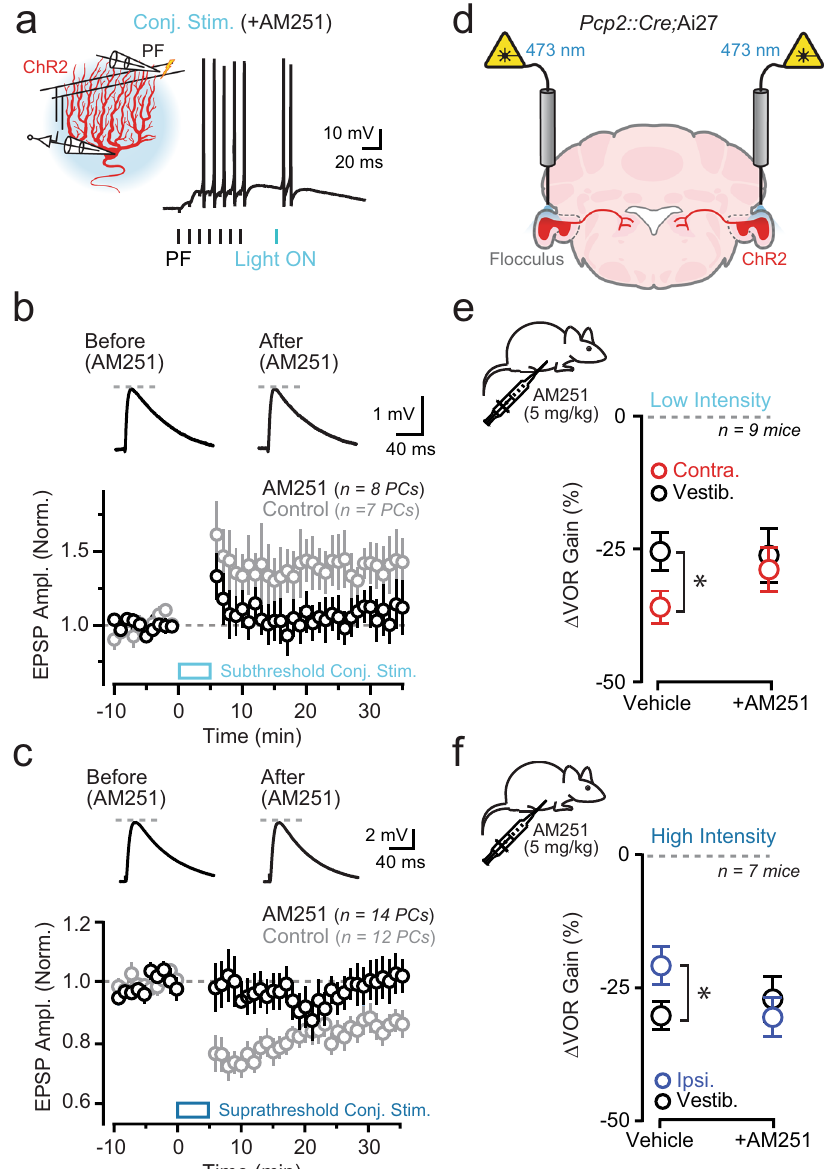
Fig. 4 Optogenetically induced plasticity and learning requires endocannabinoid signaling. a In the presence of the CB 1 receptor antagonist AM251 (5 μ M), a parallel fi ber (PF) tetanus (100 Hz, 70 ms) was repeatedly paired (300 repetitions; 1 Hz) with a light pulse ( λ 461 nm; 5 ms; either 0.13 or 1.7 mW/mm 2 ) to activate ChR2-expressing PCs. b , c Top: average parallel fi ber-evoked EPSPs recorded in PCs before and after conjunctive pairing with an optogenetic stimulus either subthreshold or suprathreshold for dendritic spike fi ring. Bottom: plots of average EPSP amplitude across PCs for control recordings (gray) or in the presence of AM251 (black). Data obtained from 24 mice total. d During training, ChR2-expressing PCs in the fl occulus were activated using optogenetic stimuli (12 pulses, 5 ms, 50 Hz) in conjunction with vestibular motion (1 Hz). Either vehicle (containing saline + DMSO) or AM251 (5 mg/kg in saline + DMSO) was administered 20 min prior to training. e , f Summary data for mice trained with either low- or high-intensity optogenetic stimuli timed to the end of contraversive or ipsiversive vestibular motion, respectively, after being administered vehicle or AM251. Separate sessions also included vestibular-only training in the same pharmacological conditions. Low-intensity stimulation, vehicle: vestibular vs. contraversive stimulation, P < 0.05; AM251: vestibular stimulation vs. contraversive stimulation, P > 0.05. High-intensity stimulation, vehicle: vestibular vs. ipsiversive stimulation, P < 0.05; AM251: vestibular vs. ipsiversive stimulation, P > 0.05. All data are mean ± SEM; asterisk indicates P < 0.05, two-way repeated measures with Sidak ’ s post AAV-mediated transduction of Cre-dependent ChR2-K v 2.1 in simple spiking on induced changes to VOR performance from those attributable to the dendritic Ca 2 + response, we avoided Pcp2::Cre mice resulted in a predominant somatic localization of ChR2 in PCs, although there was a modicum of expression in expressing ChR2 in PC dendrites that drive local Ca 2 + elevation in their arbors. We achieved this by attaching the somatic tar- their proximal dendrites (Fig. 5a). As shown in cerebellar slice geting motif of the K v 2.1 K + channel to the c -terminus of ChR2 recordings from PCs expressing ChR2-K v 2.1, short light pulses (ChR2-K v 2.1) 49 – 51 . drove well-timed somatic simple spikes without evoking